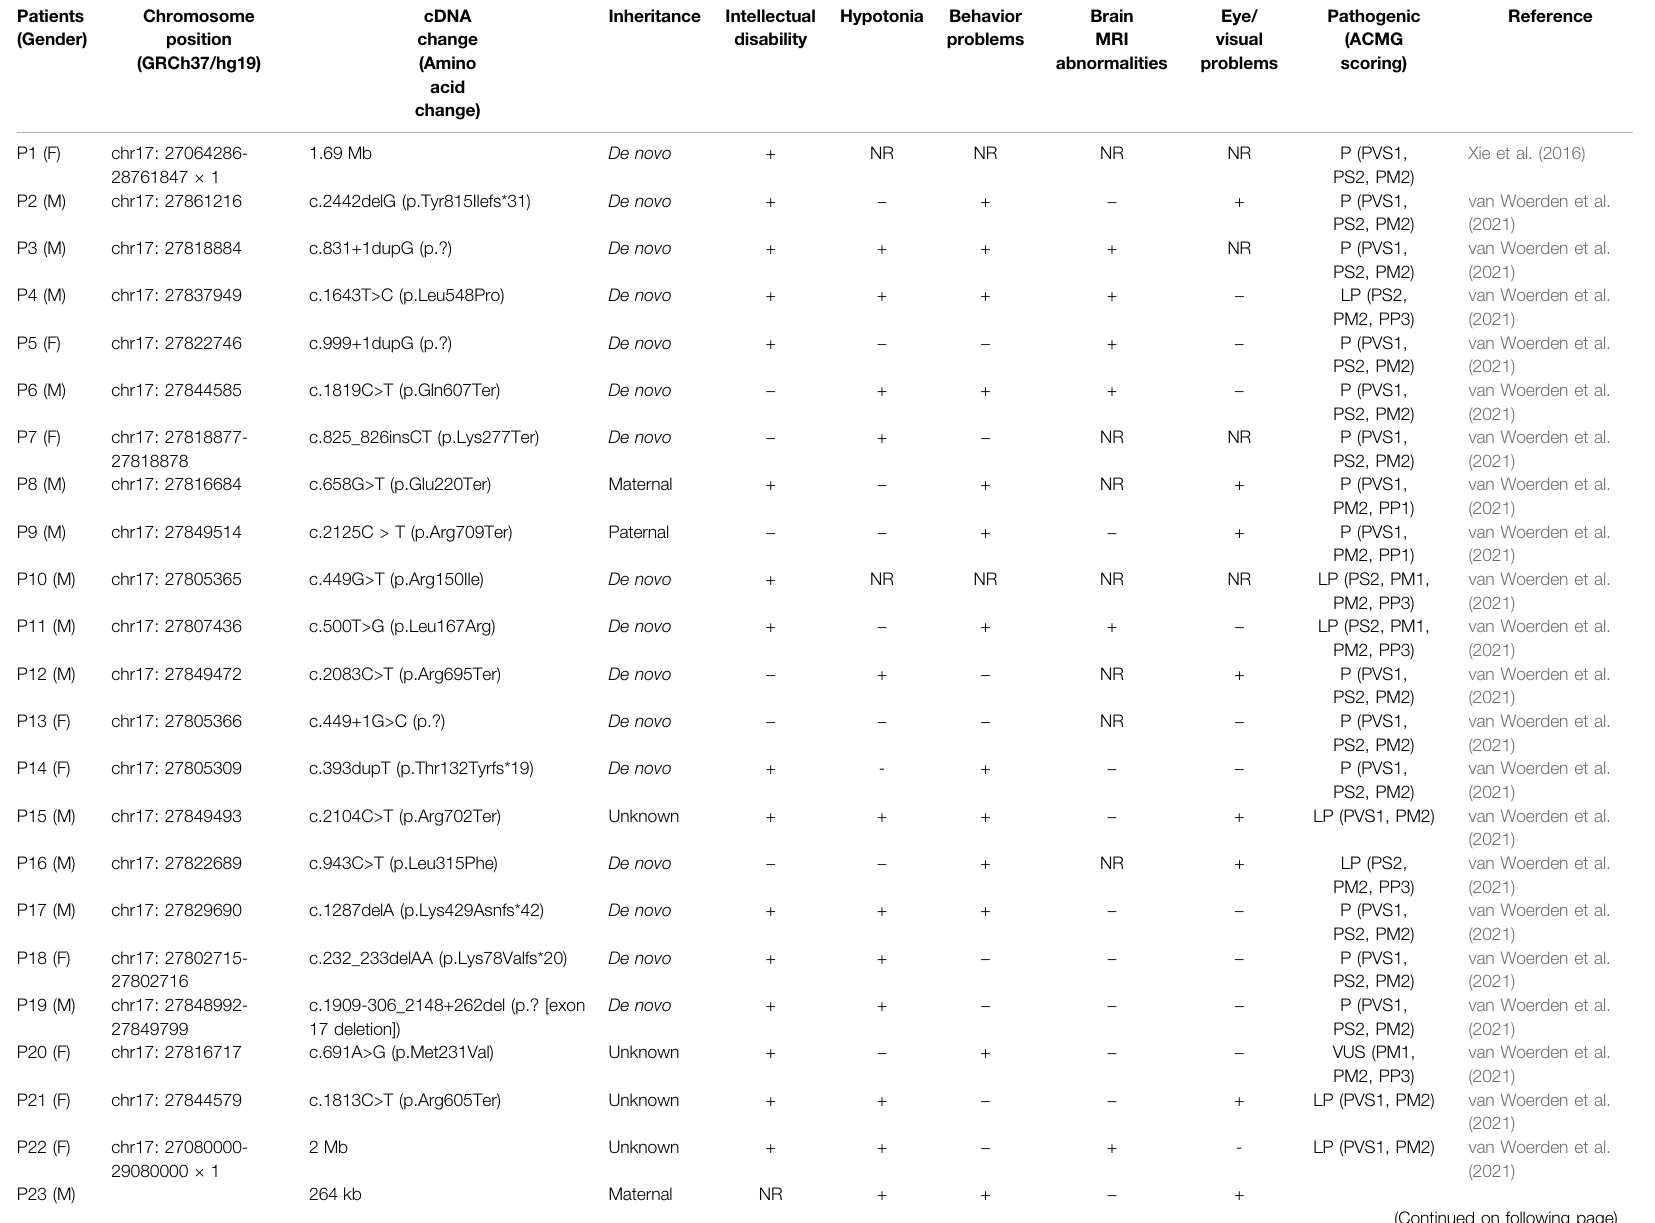
TABLE 1 | Overview of the identi fi ed variants of TAOK1